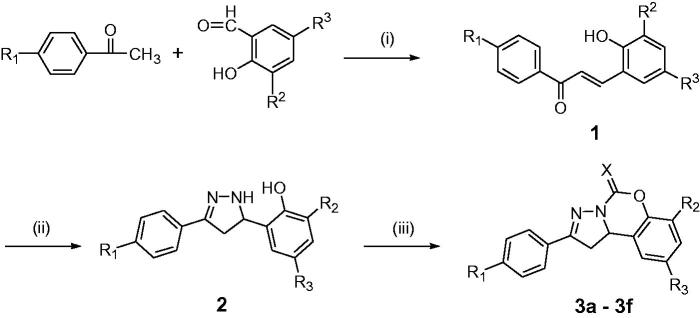
Synthesis of compounds 3a–3f. Reagents and conditions: (i) 40% NaOH solution, EtOH, 60 °C; (ii) N2H4·H2O, EtOH, reflux; (iii) N,N′-carbonyldiimidazole or 1,1′-thiocarbonyldiimidazole, CH2Cl2, r.t.